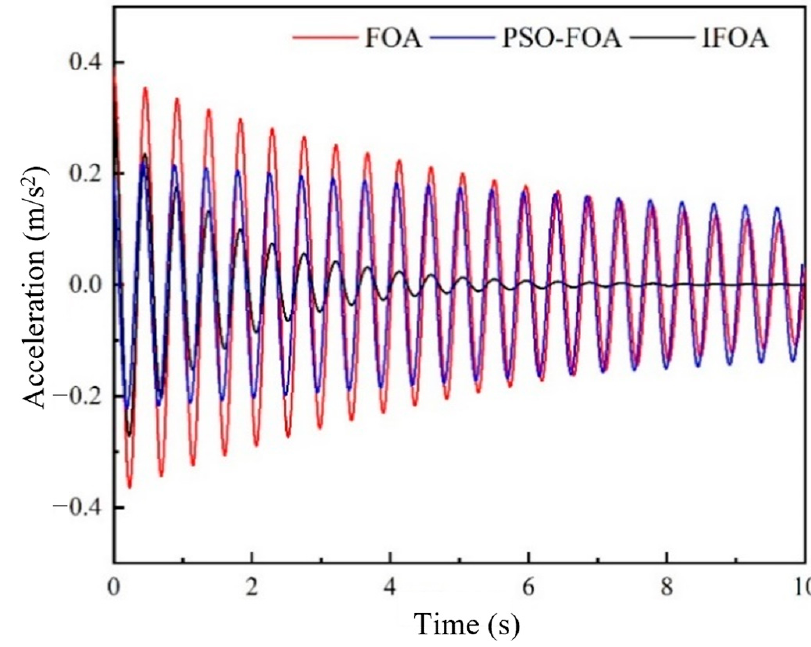
Figure 12. Vibration acceleration of vehicle body (n = 890 r/min).